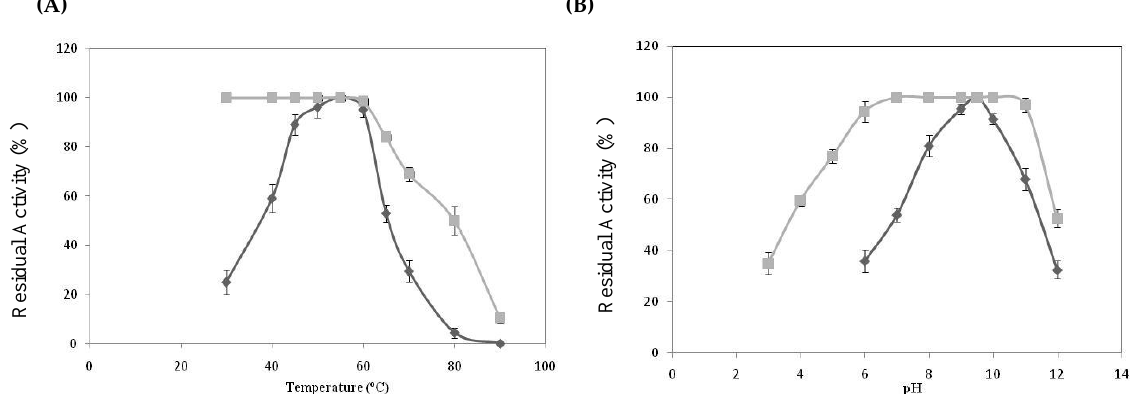
Figure 5. ( A ) Effect of pH on pure amylase activity and stability. For pH activity, the relative activity was measured by incubating pure enzyme with starch substrate at different pH values (6-12). Buffers used are as follows: A phosphate buffer, pH 6.0–8; glycine–NaOH buffer, pH 9.0–12.0. pH stability of pure amylase was determined by incubation for 1 h at specified pH values (with buffers cited above). Results are the average of triplicate experiments. ( B ) Effect of temperature on pure amylase activity. The enzyme was incubated with the substrate for 1 h at different temperatures for 1 h. Thermostability of amylase was determined by prior incubating sole pure enzyme at temperature for 1 h. Results are the average of triplicate experiments.